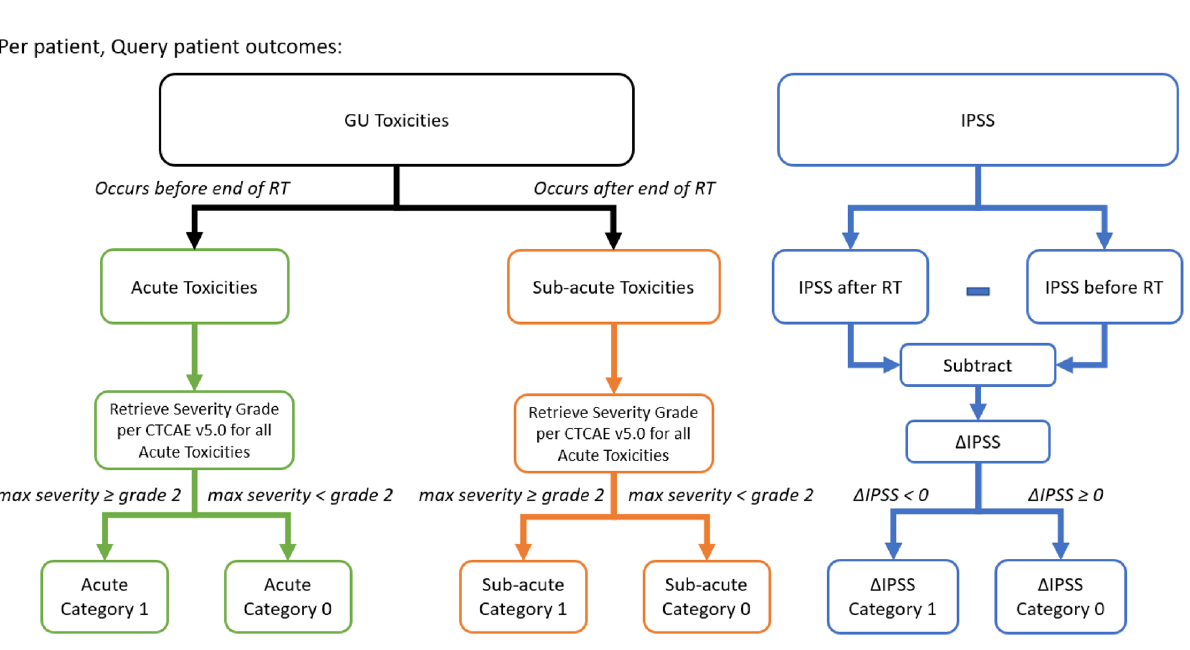
Figure 2. Visual representation of categorization of clinical endpoints for this